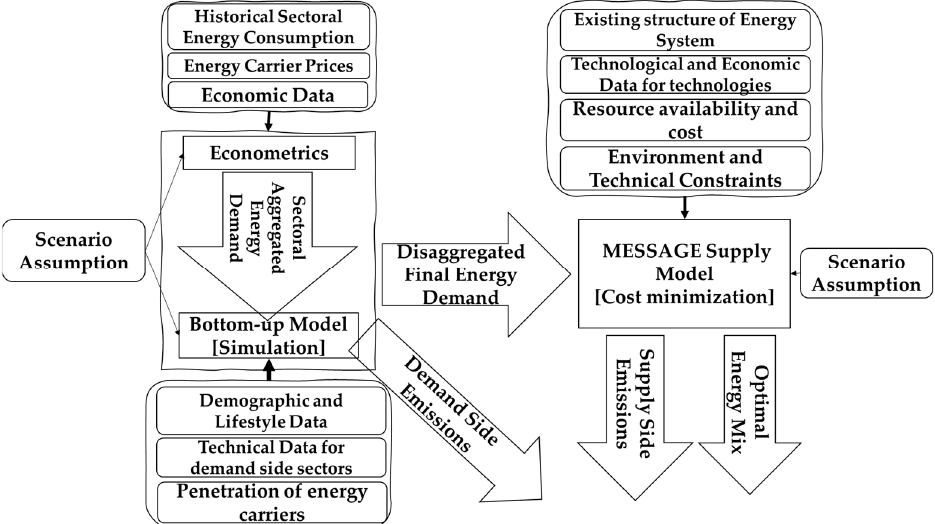
Figure 7. Integration of demand and supply models in this study.